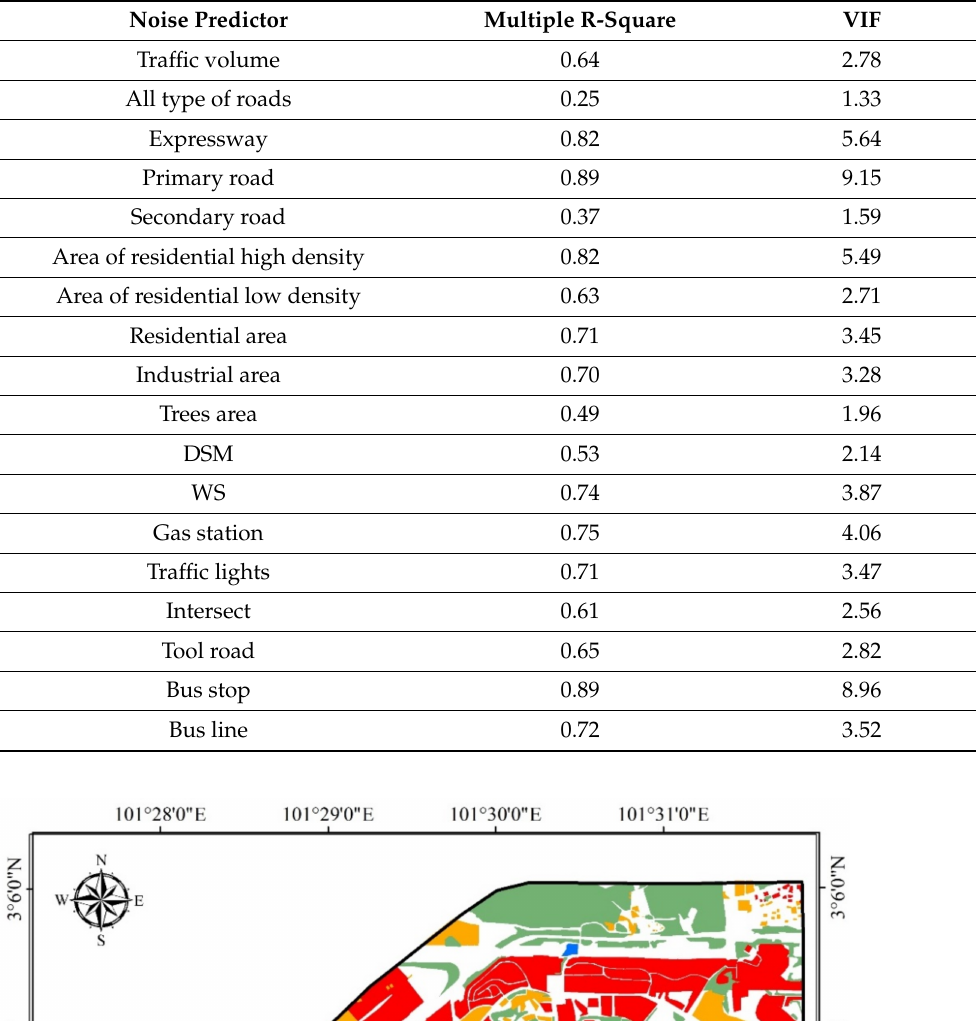
Table 2. Results of assessing the contribution of noise predictors using the chi-square method.